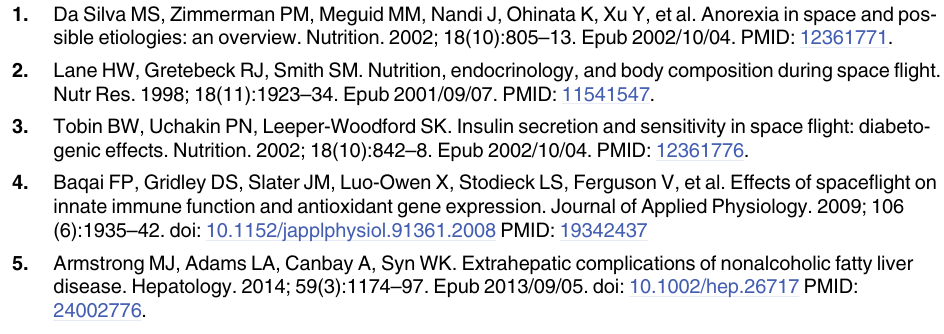
S1 Table. Pump wavelengths corresponding to the Raman shifts of interest for CARS imag- quency region of the fingerprint band. S2 Table. Biochemicals identified in spaceflight (FLT) and ground control (AEM) livers. S3 Table. Raman shifts and associated molecular vibrations. S4 Table. Genes, pathways and processes associated with metabolites upregulated in space-